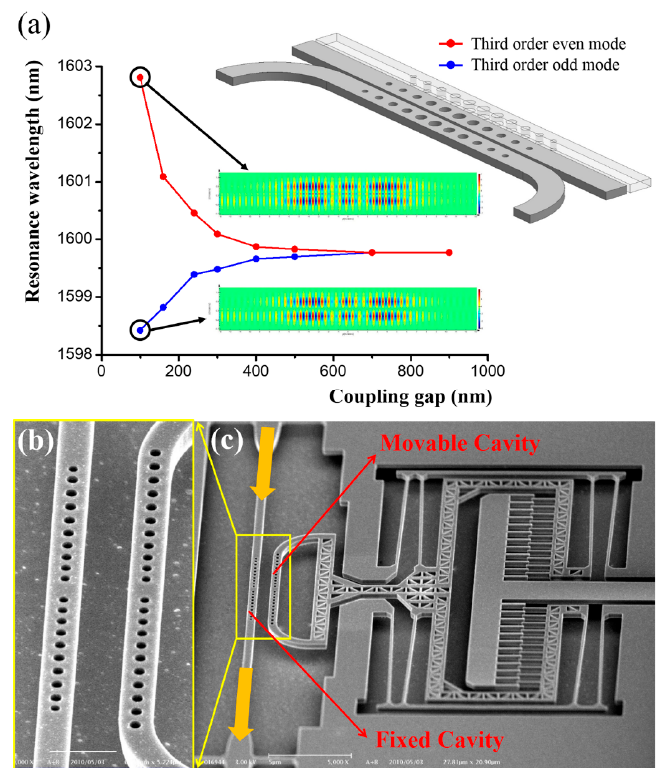
Figure 10. ( a ) FDTD simulation result of the third order even and odd modes indicating the wavelength shift of dual-coupled nanobeam cavities with respect to coupling gap variation. The mode profiles (when coupling gap is 100 nm) are inserted. ( b , c ) SEM images of (b) close-up view of the dual-coupled nanobeam cavities and (c) NEMS comb drive controlled dual-coupled nanobeam cavities